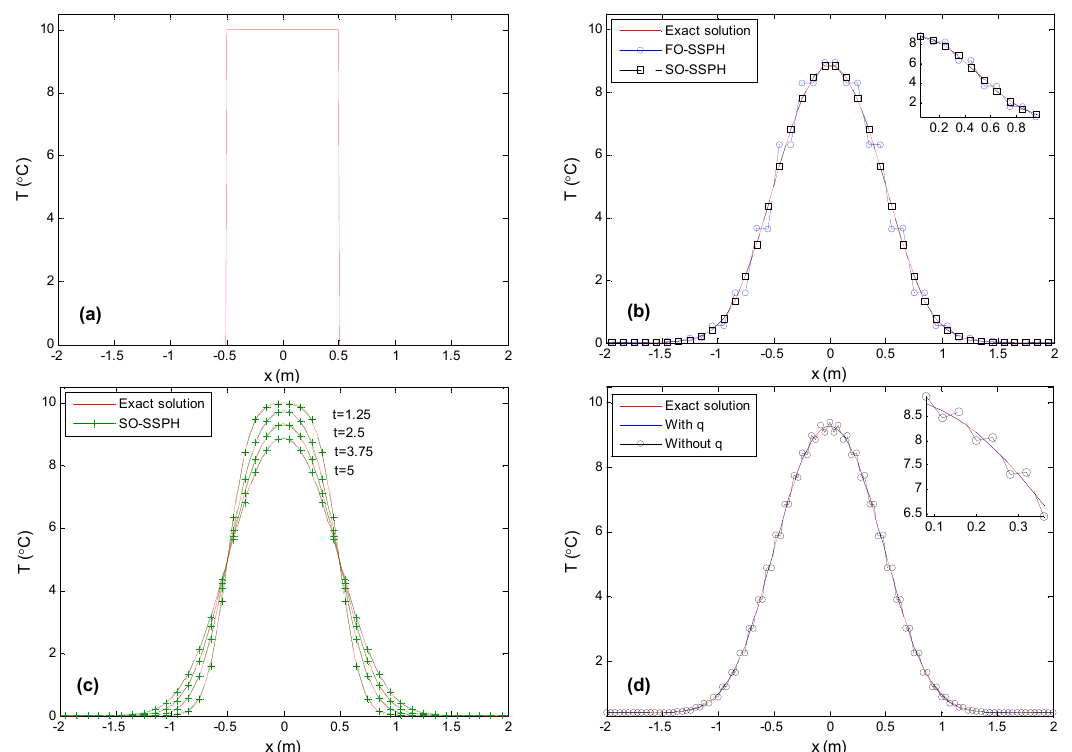
Figure 1. One-dimensional heat conduction with discontinuous initial temperature distribution: ( a ) initial condition; ( b ) results of FO-SSPH and SO-SSPH compared with exact solution; ( c ) SO-SSPH solutions at difference times; and ( d ) FTCS solutions for Equation (6) (with heat fluxes) and Equation (5) (without heat fluxes).